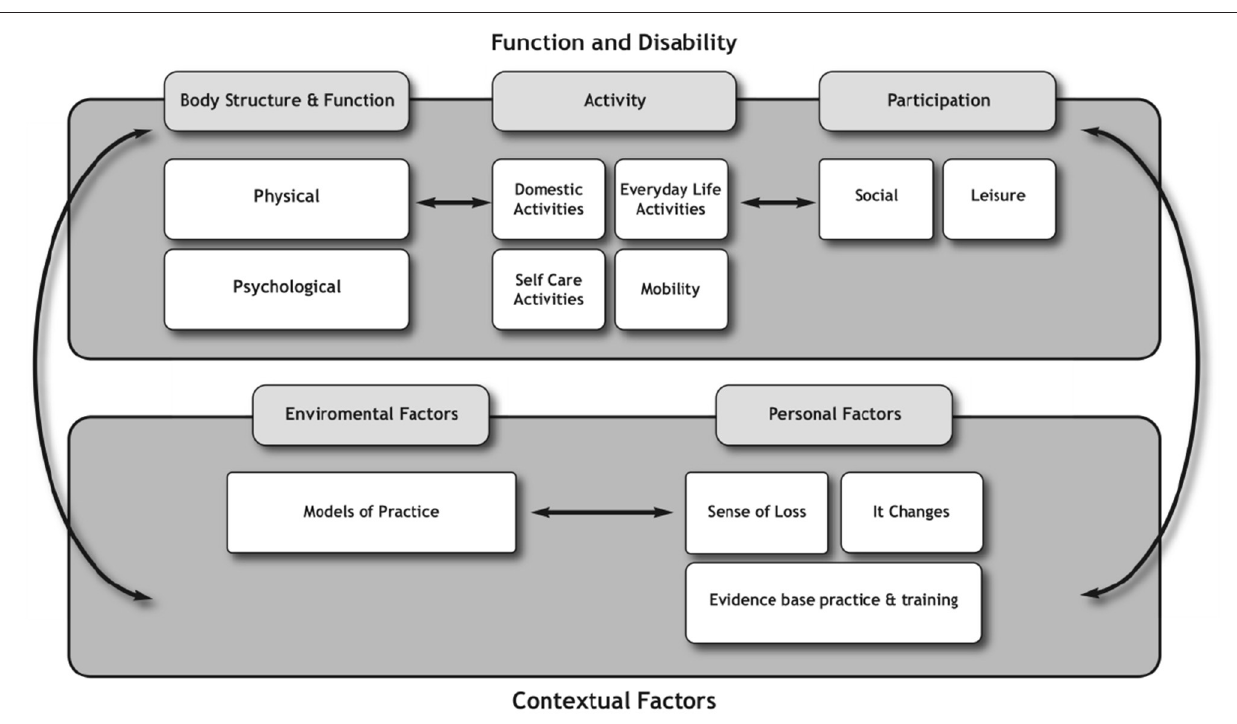
Frontiers in Rehabilitation Sciences |